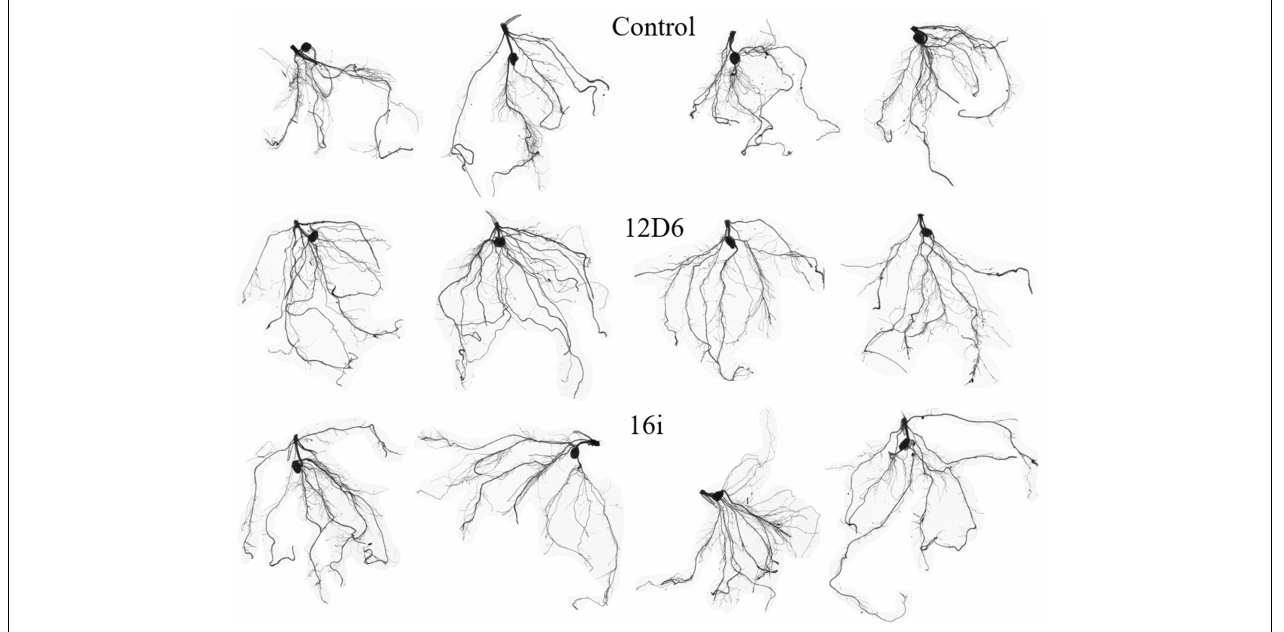
FIGURE 4 | Root system architecture in maize seedlings treated with the control (top) , Bacillus sp. (12D6) (center) and Enterobacter sp. (16i) (bottom) after exposure to 7 days of continuous water